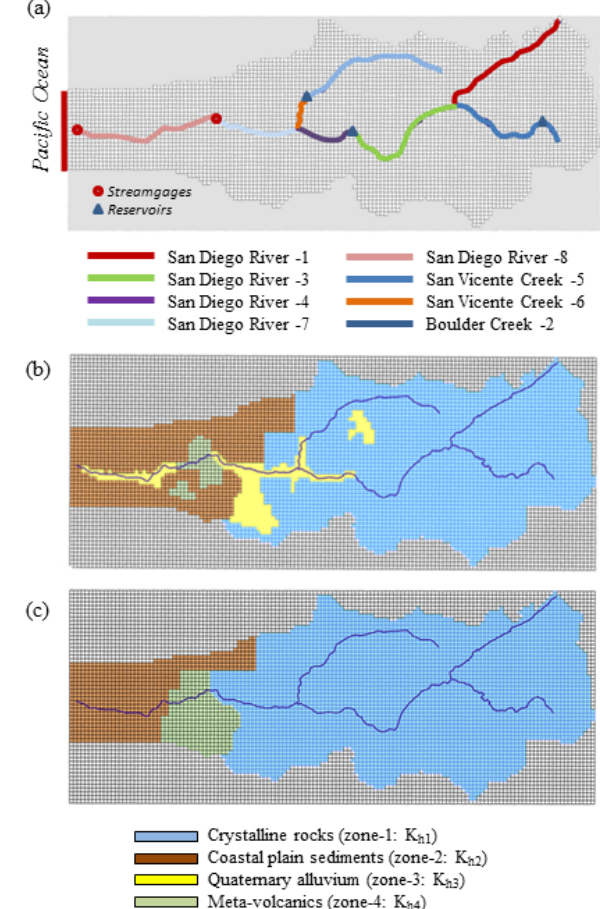
Fig. 7. Plan view of the San Diego River basin groundwater flow model domain illustrating the (a) grid, Streamflow Routing (SFR) Package boundary stream segments (indicated in legend, numbers correspond to Table 2), and Drain (DRN) Package boundary (red bar labeled as Pacific Ocean), and the geologic zones used in the (b) model layer 1, and (c) model layers 2 and